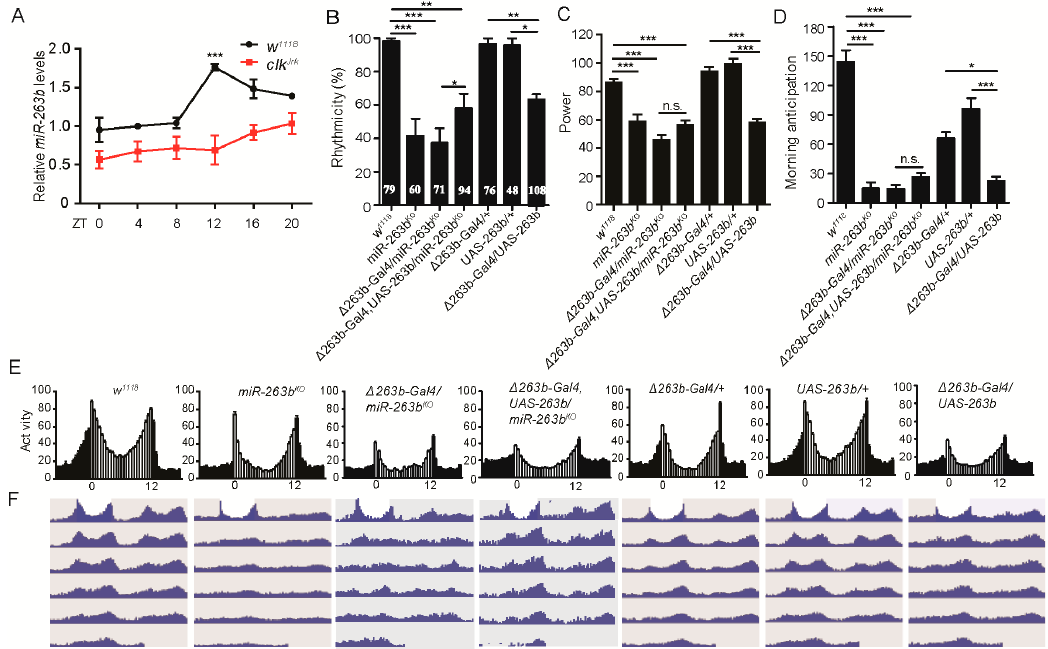
Figure 1. miR-263b is rhythmically expressed and regulates circadian behavior. ( A ) Quantitative PCR analysis of miR-263b from adult brains of wild-type and Clk Jrk mutant flies at the indicated time points. The relative expression levels were normalized to 2s ribosomal RNA (rRNA) and were further normalized to w 1118 at ZT0. Each time point was compared to ZT0. Data represent means ± standard error of the mean (SEM); *** p < 0.001 determined by Student’s t -test. ( B – D ) Comparison of ( B ) rhythmicity, ( C ) power, and ( D ) morning anticipation index in indicated fly strains. Data represent means ± SEM ( n = 45–79); * p < 0.05, ** p < 0.01, *** p < 0.001 determined by Student’s t -test. ( E ) Locomotor activity of indicated strains measured during three days of light–dark (LD). The white and black bars indicate day and night, respectively. ( F ) Actograms showing the average activities on the last day in LD and five days in constant darkness (DD). Light represents the day, and gray represents the